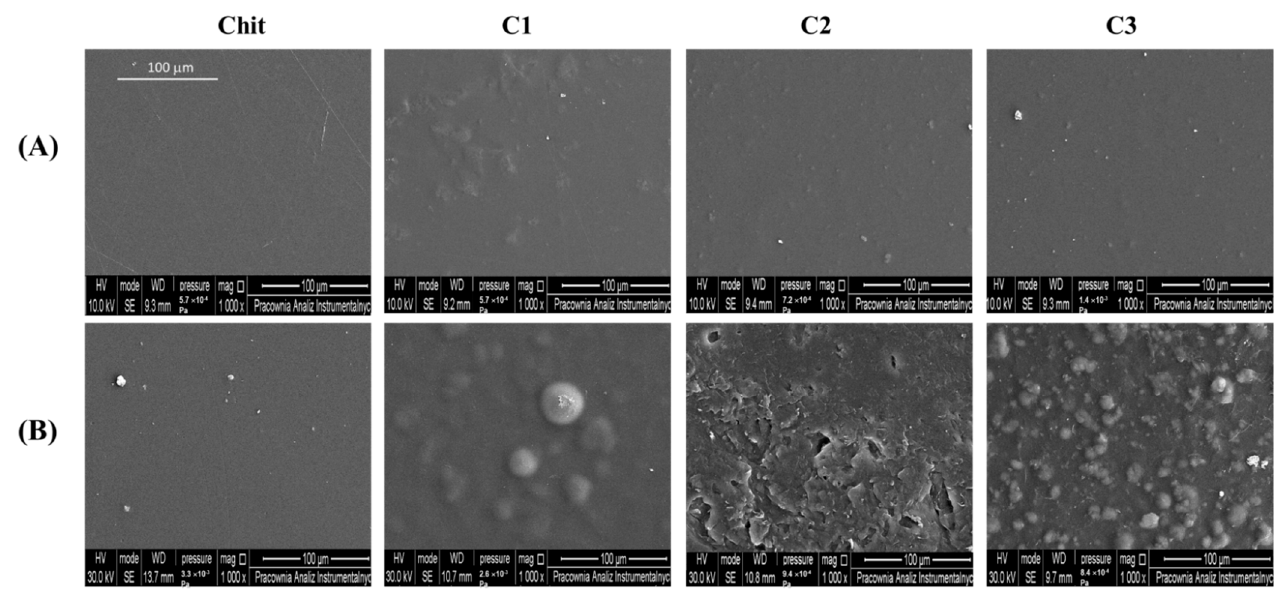
Figure 4. Representative SEM images of film surface of different composition ( A ) before and ( B ) after NaOH treatment (magnification ×1000, bar = 100 μ m). Table 3. Roughness parameters of films with various compositions before and after NaOH